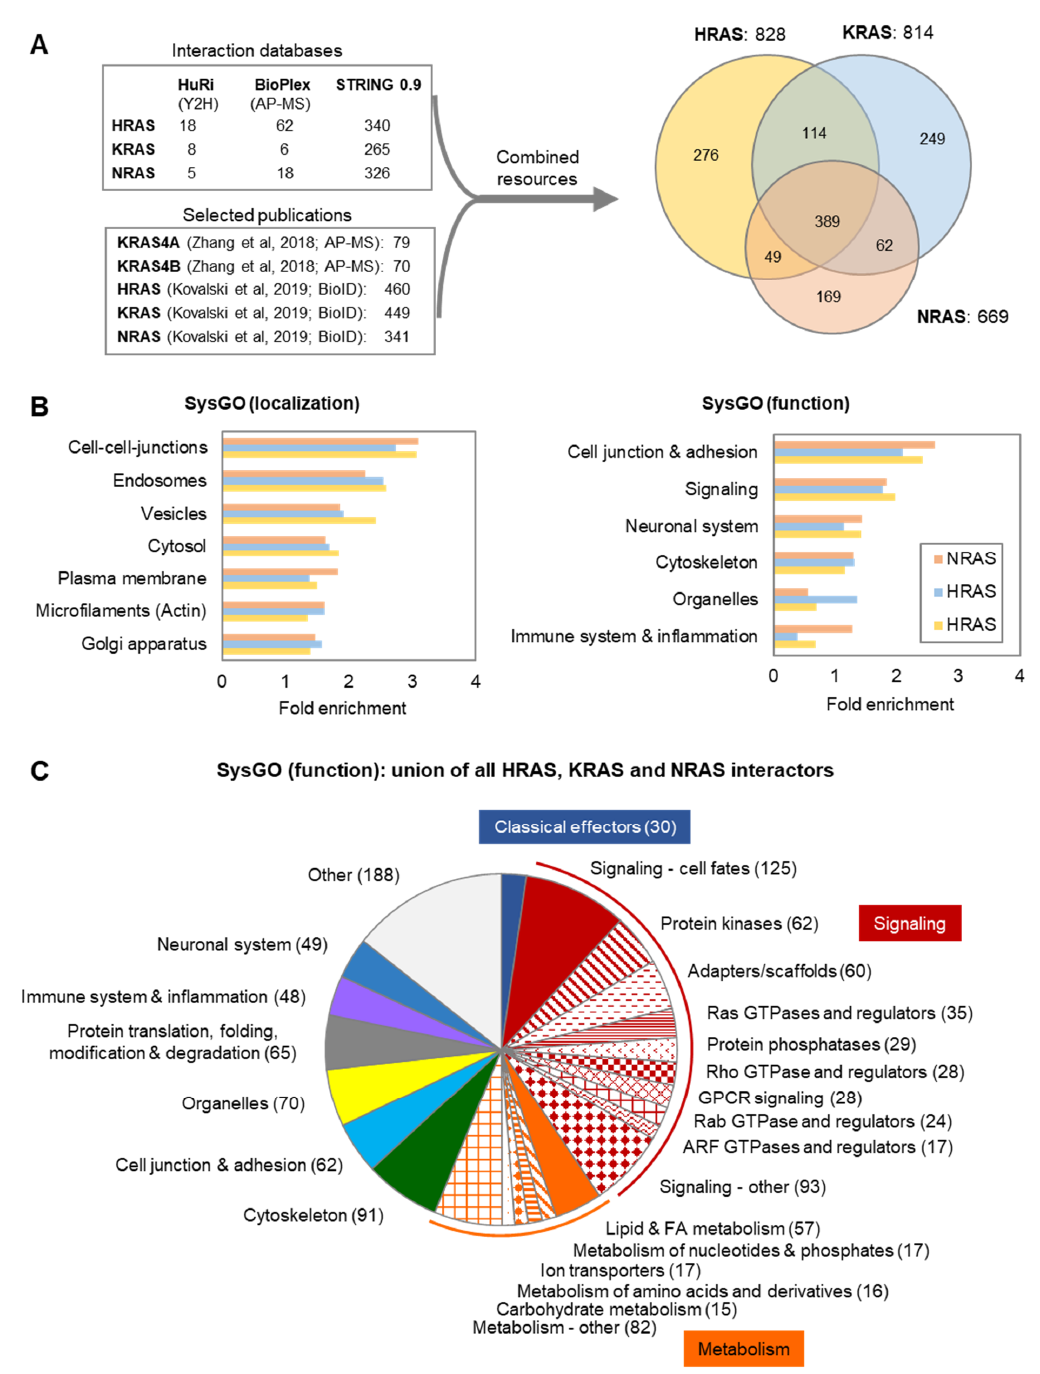
Figure 7. The RAS network as defined by interaction proteomics. ( A ) The RAS network obtained from databases and recent publications. Overview of interactions obtained from the HuRI, BIOPLEX, and STRING (highest confidence; 0.9) databases, and two recent publications [133,134] (left side). Venn diagram of interactions for HRAS, KRAS and NRAS (right side). ( B ) Enrichment of functional classes for HRAS, KRAS and NRAS interactors based on the SysGO database. ( C ) Functional analysis of all proteins in the union of HRAS, KRAS and NRAS interactors. Abbreviations: FA, fatty acids; Y2H, yeast two hybrid.